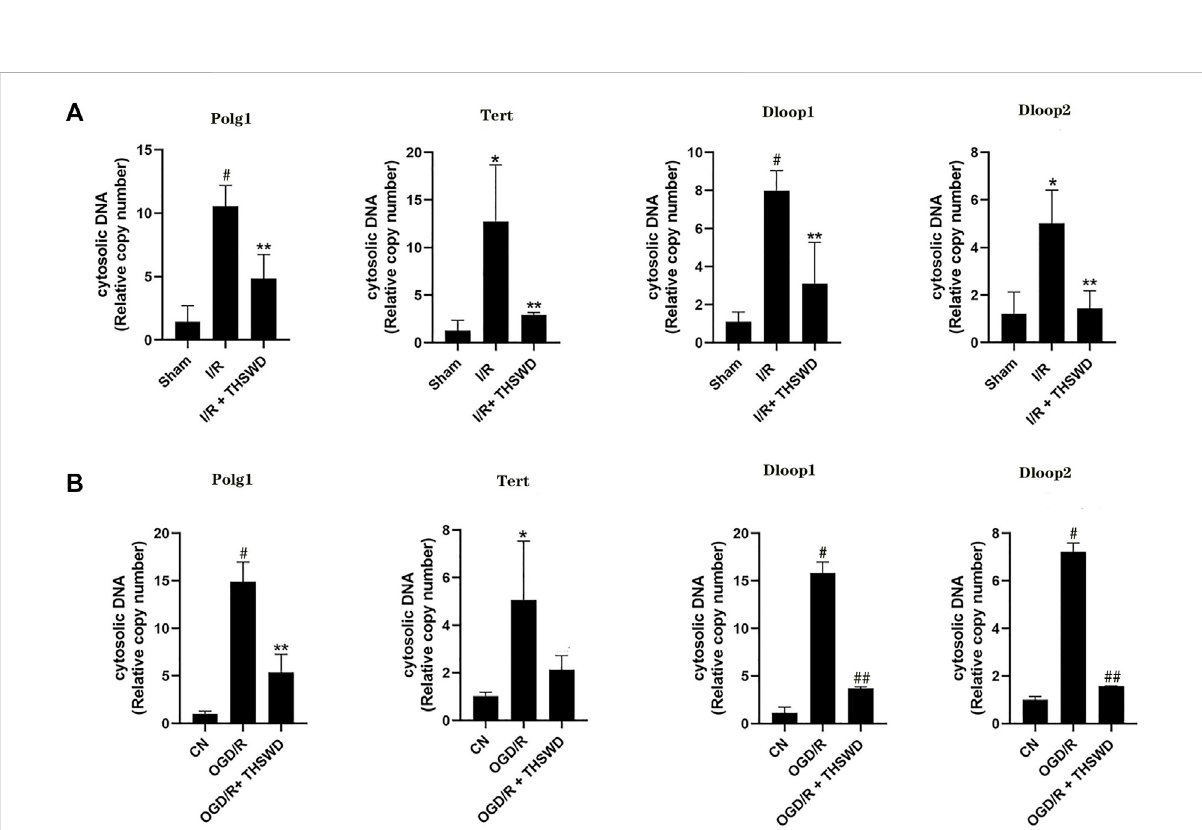
FIGURE 8 DNA) testing. Notes: (A) animal models (B) cellular models. A * p < 0.05, # p < 0.01 vs. Sham group; ** p < 0.05 vs. I/R group. B * p < 0.05, # p < 0.01 vs. CN group; ** p < 0.05, ## p < 0.01 vs. oxygen-glucose deprivation/reoxygenation (OGD/R)